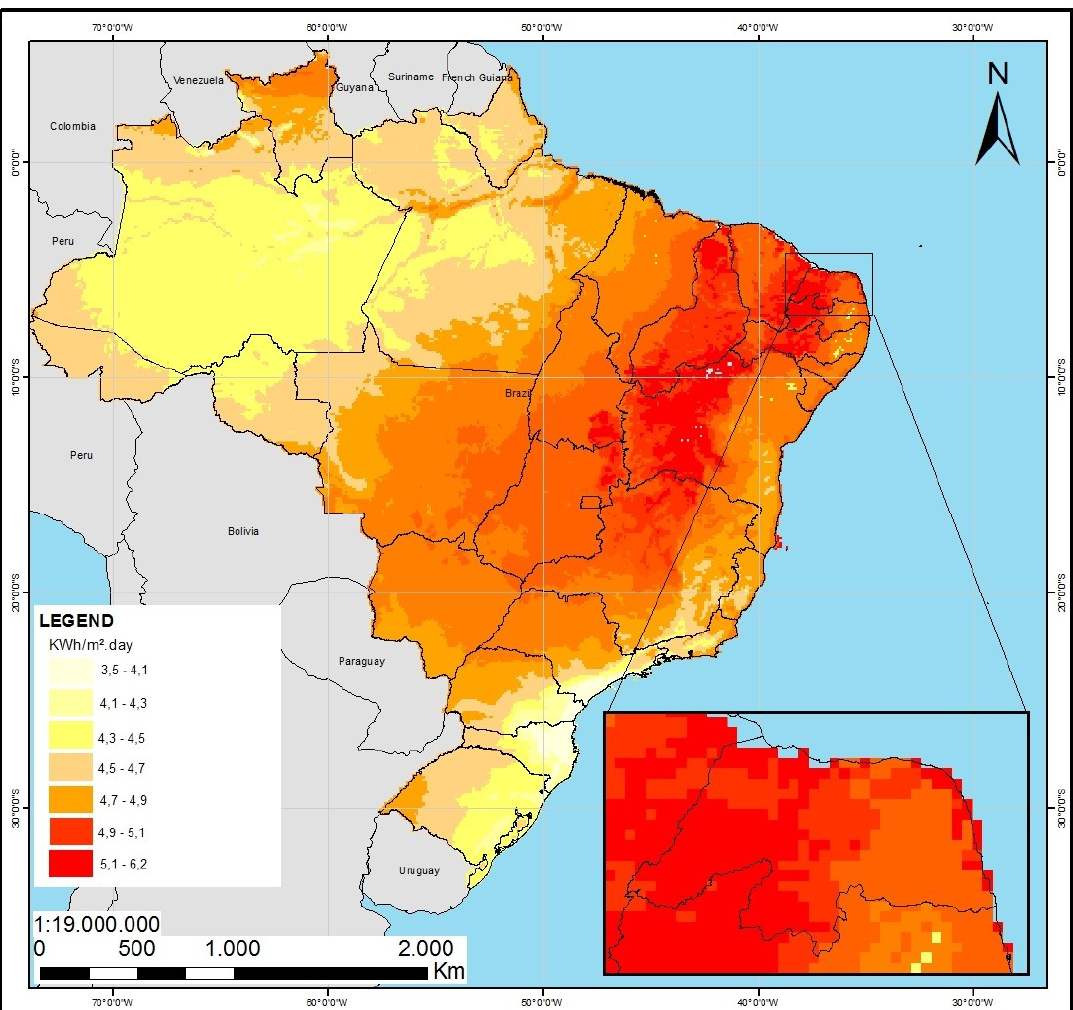
Figure 7. Annual average daily horizontal radiation. The Datum Sirgas 2000 coordinate system was used; the data were sourced from References [64,66].